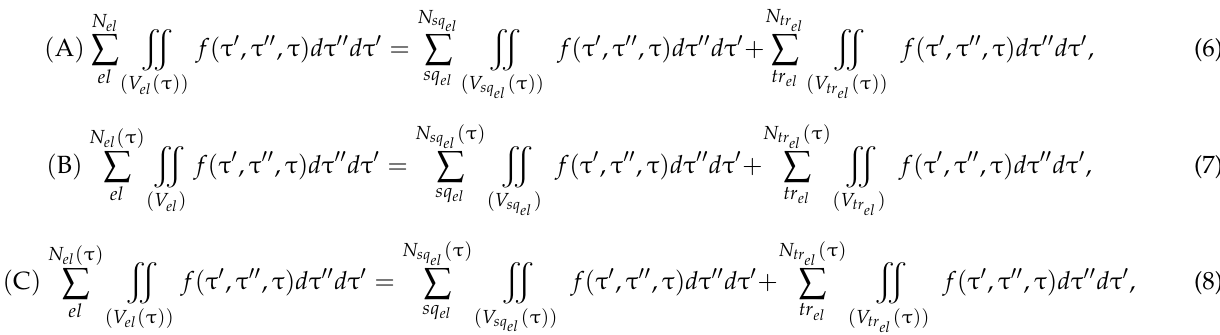
where sq is the square element, el numbers of square and triangular elements, and triangular elements,